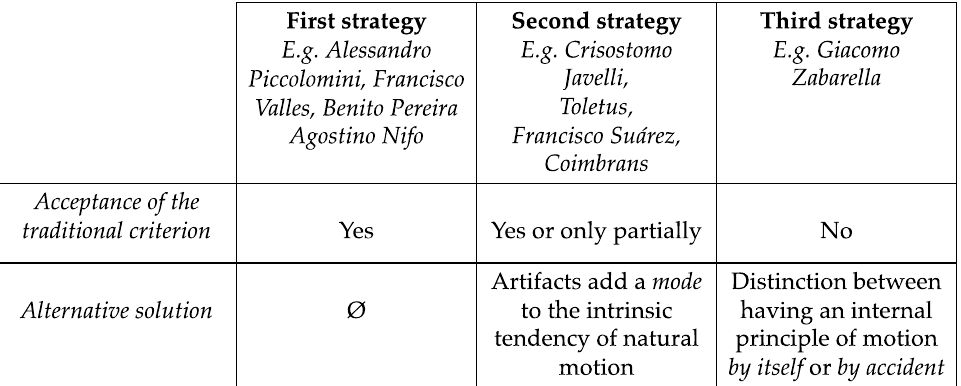
Figure 3. Types of beings and classification of artifacts according to Zabarella.